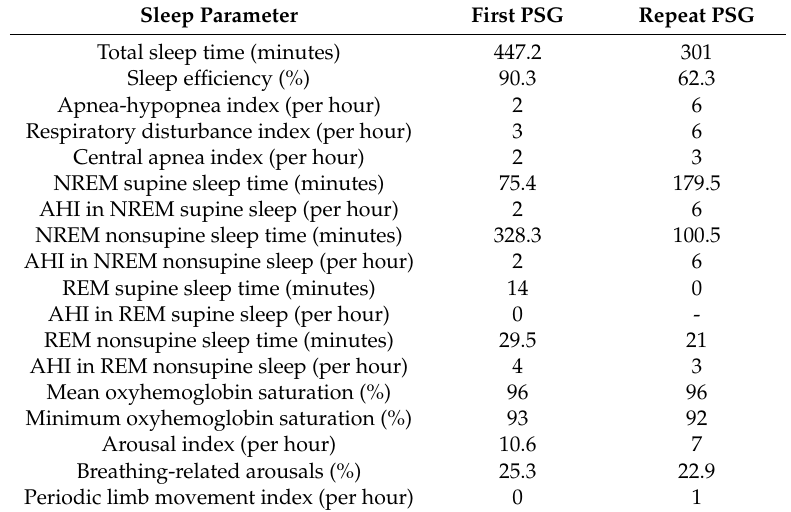
Table 2. Sleep parameters during the first and second polysomnograms. Sleep Parameter First